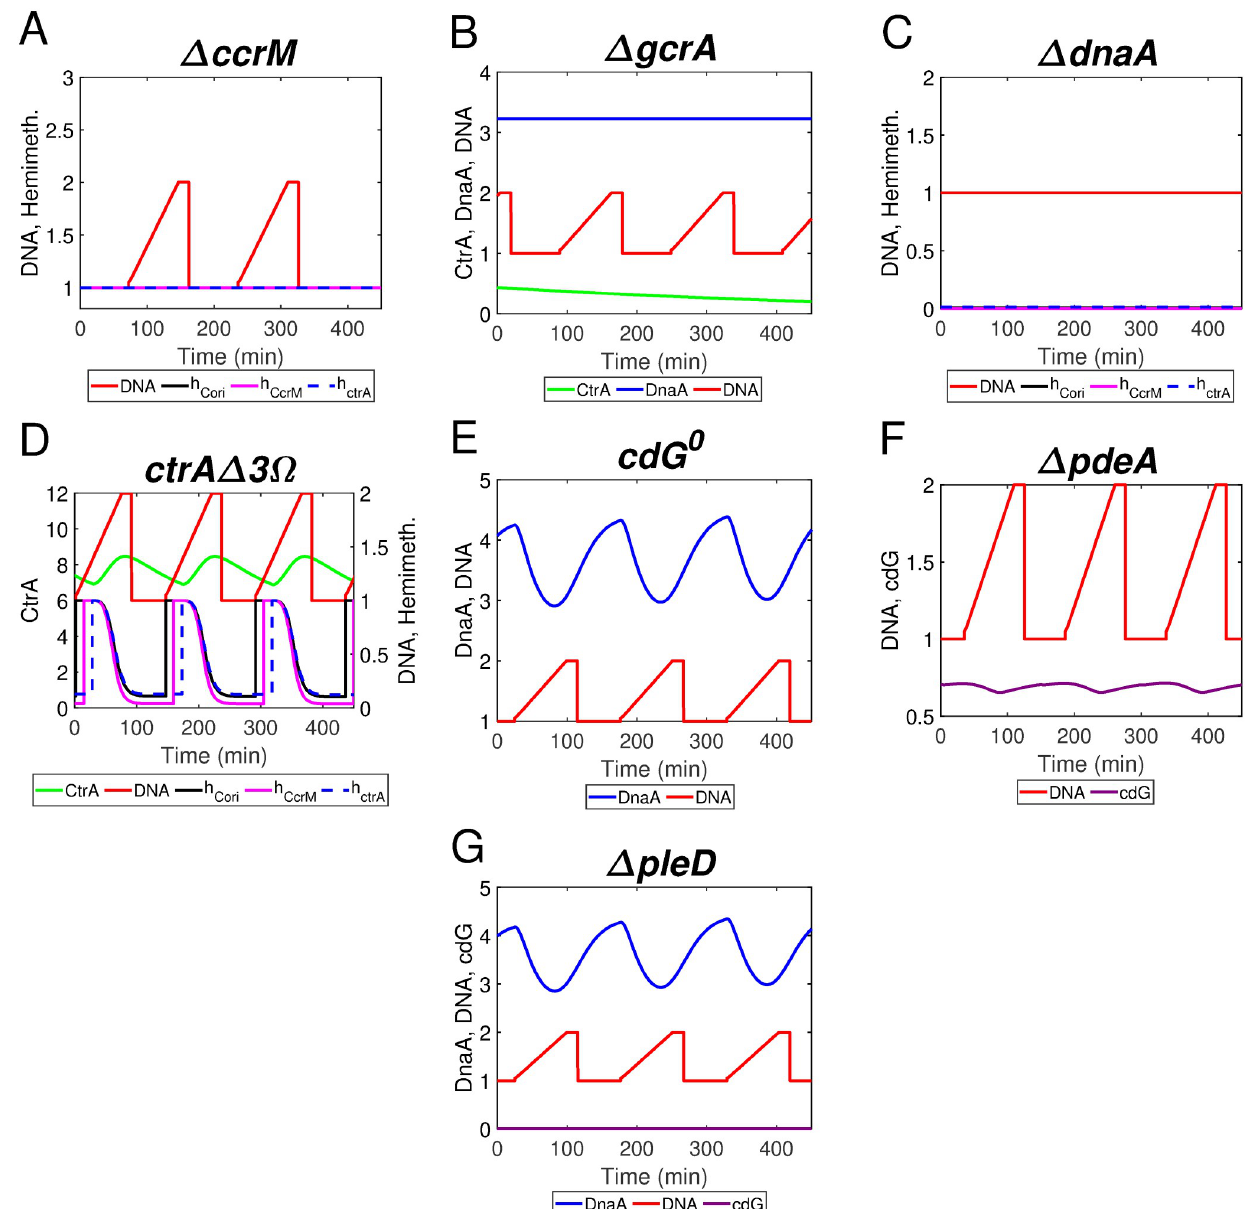
Fig 13. (A-G) Simulated results of mutant strains: Δ ccrM , Δ gcrA , Δ dnaA , ctrA Δ 3 O , cdG 0 , Δ pdeA , and Δ pleD . In knock out mutant simulations, we set k s,i = 0, where i indicates corresponding species including ccrM , gcrA , dnaA , cdG, PdeA, and PleD. In the simulation of ctrA Δ 3 O ,the cyclic proteolysis rate of CtrA is reduced to